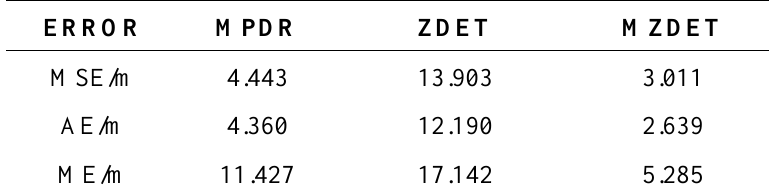
Table 4. Error analysis of the three